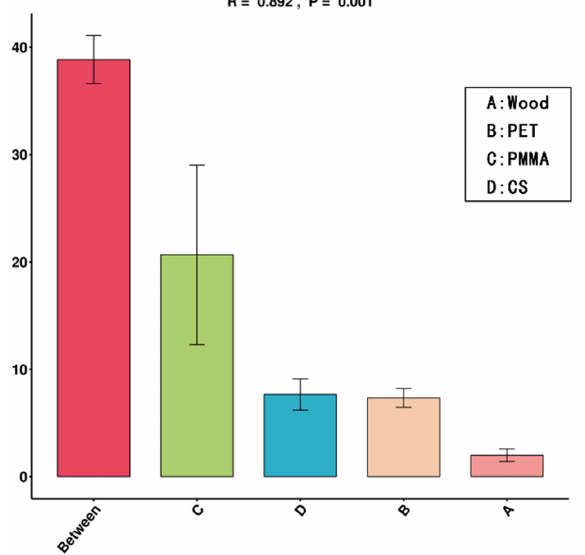
Figure 7. Anosim result of A (Wood), B (PET), C (PMMA), and D (CS) substrates. The ordinate stands for the ranks of distances between or inside the groups. The R value is 0.892, quite close to 1, indicating that distances between groups are larger than distances within groups. p value is 0.001, indicating that these differences are statistically significant. Table 1. Adonis result of A (Wood), B (PET), C (PMMA), and D (CS) substrates.